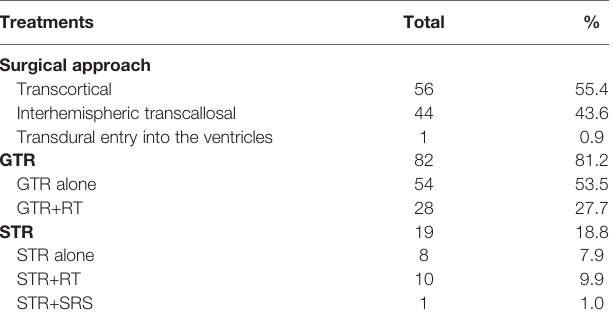
TABLE 2 | The treatment modality for patients with